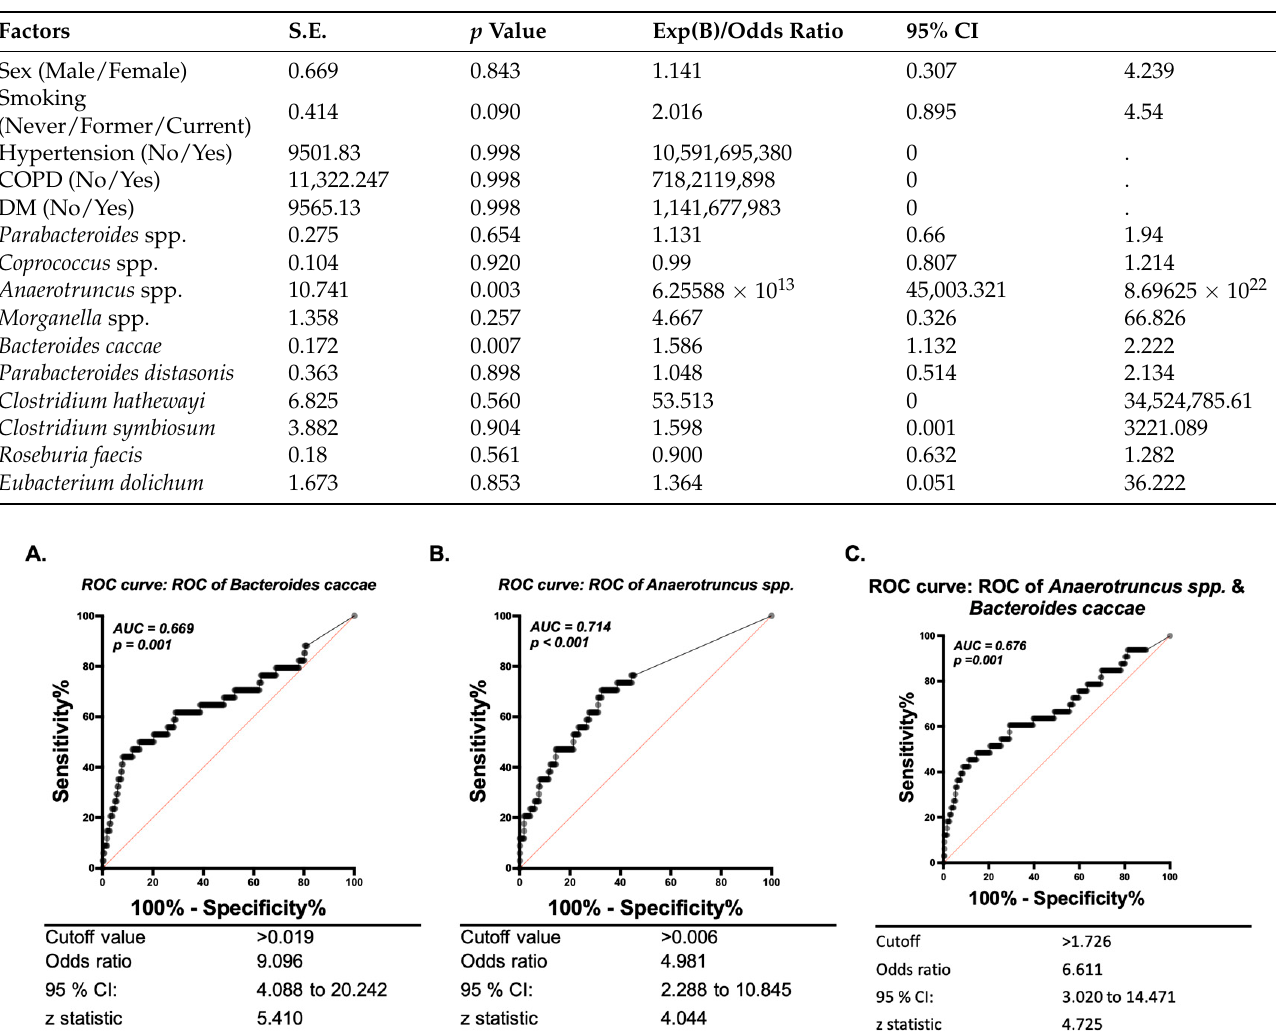
Table 2. Multivariate regression analysis for lung cancer risk.